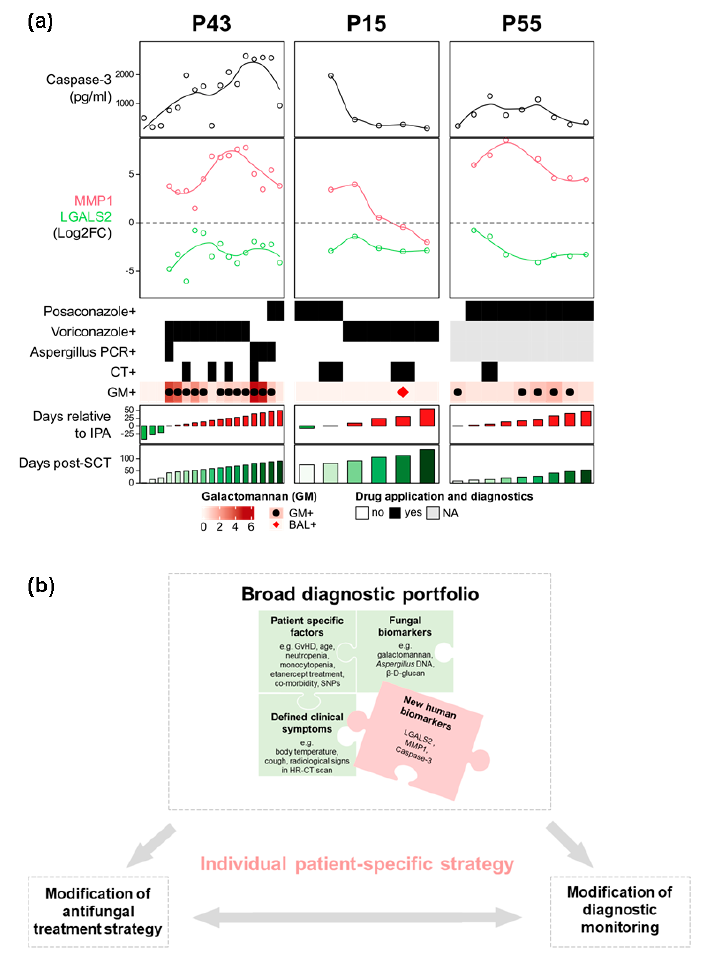
Figure 7. ( a ) Integrated biomarker-based profile of three investigated probable IPA cases and three controls. A proposed integrated profile consists of the suggested biomarker candidates ( LGALS2 , MMP1 , and caspase-3), performed diagnostic tests ( Aspergillus PCR, Galactomannan assay, and HR-CT), and collected clinical information (e.g., antifungal treatment, cell counts). Investigated time points with patients undergoing drug treatment and positive diagnostic tests are marked in black. In cases where HR-CT was not performed on the exact date of blood collection, results for positive CT are indicated closest to the investigated time point. GM+, Galactomannan positive for A. fumigatus ; BAL, Bronchoalveolar lavage sample positive for A. fumigatus . Blood concentrations were center-scaled for comparability. ( b ) Proposed individual patient-specific strategy based on the combination of human and fungal biomarkers with patient-specific